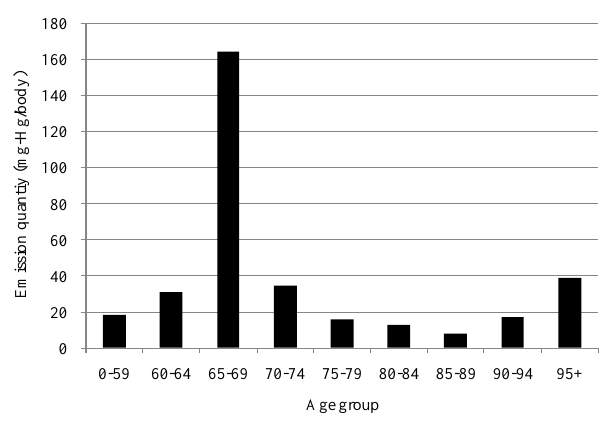
Figure 4. The distribution of emission quantities calculated using measured data. Fig. 4. The distribution of emission quantities calculated using mea- sured data.